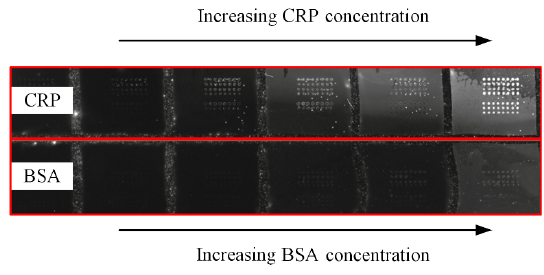
Figure 19. Optical detection of CRP bound to aptamers.